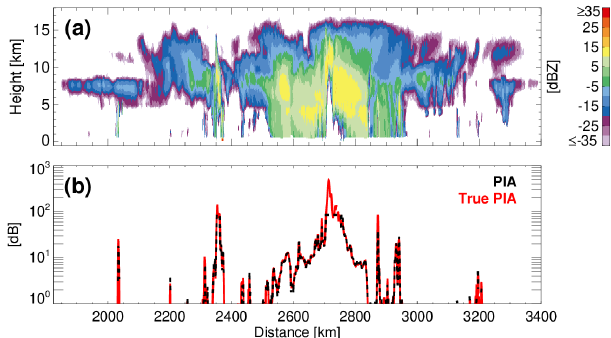
Figure 2. (a) The CPR radar reflectivity from the 1825–3400km along-track segment of the Hawaii (tropical) scene and (b) the C- FMR estimated (black like) and true (red line) PIA time series from the same segment of the Hawaii scene over the ocean.